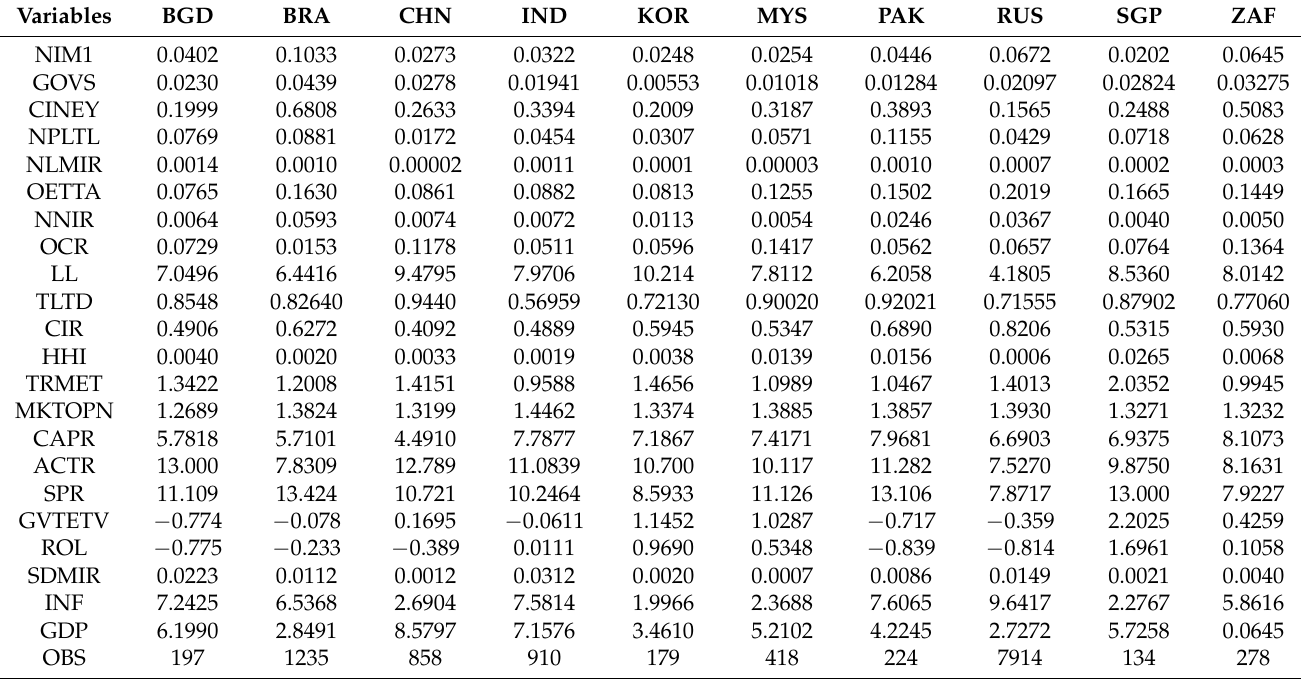
Table 3. Mean of variables